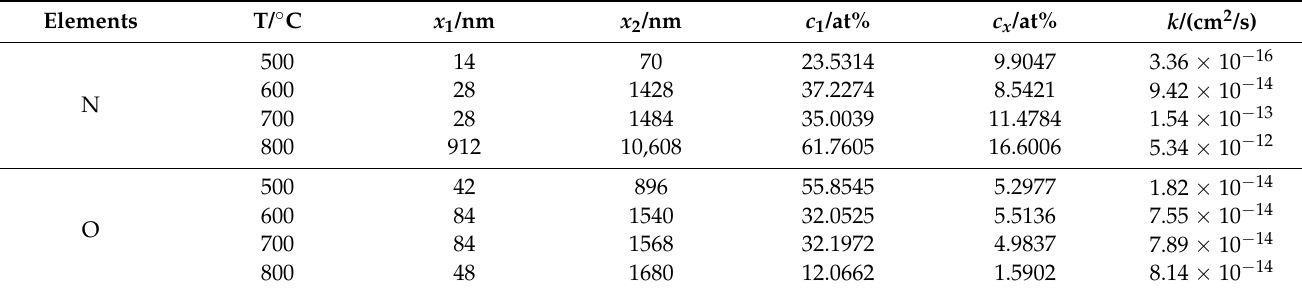
Table 5. The diffusion front was the diffusion distance when the element content tends to be constant, as x 2 . Table 5. Diffusion coefficients of N and O in zirconium hydride at different